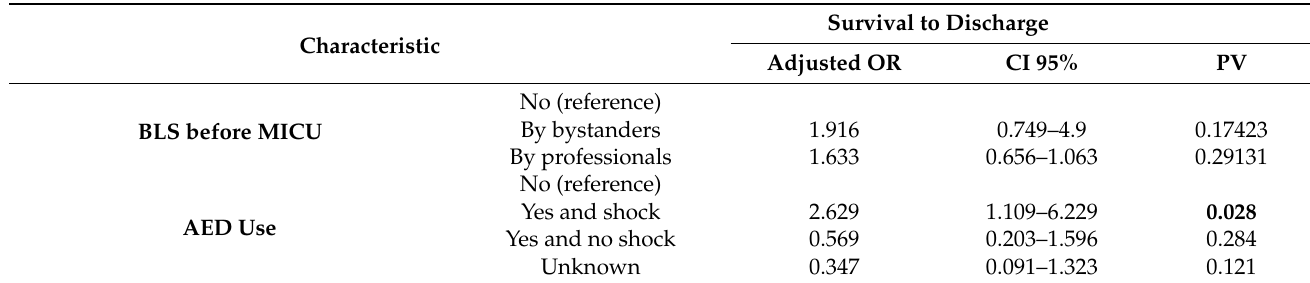
Table 4. Adjusted survival to discharge outcome according to patients’ characteristics and prehospital and hospital